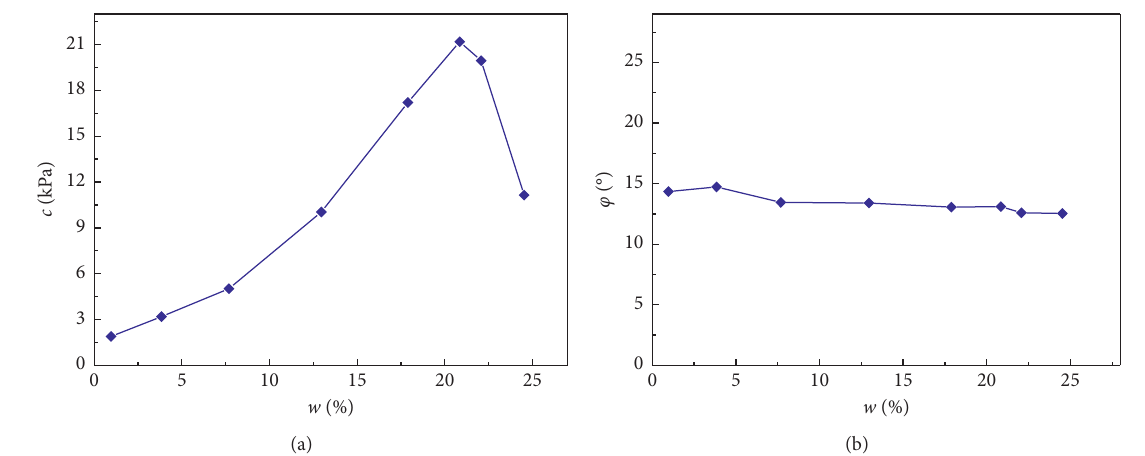
Figure 8: Cohesion (a) and internal friction angle (b) of coal under different water